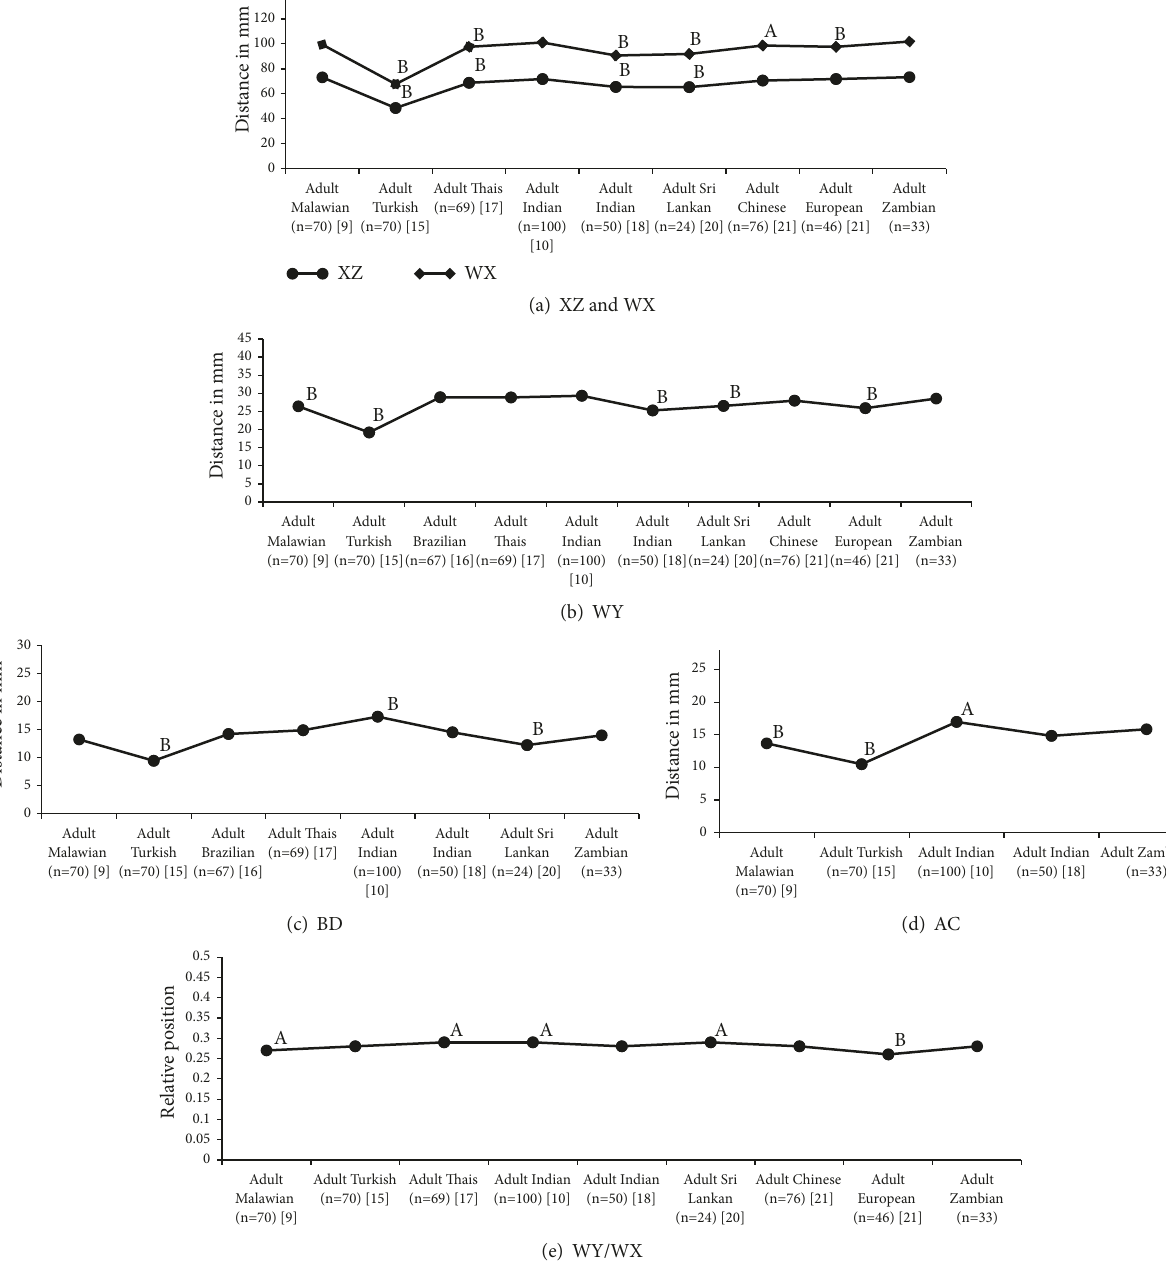
Figure 7: The mandibular anthropometrics of the right side of mandibles among different ethnic groups on different geographic locations: comparative analysis with other reported values. AC: distance (in mm) from alveolar crest to upper margin of mental foramen, BD: distance (in mm) from lower border of mandible to lower margin of mental foramen, WY: distance (in mm) from symphysis menti to medial margin of mental foramen, XZ: distance (in mm) from posterior border of ramus of mandible to lateral margin of mental foramen, WX: length of mandibles, and WY/WX: relative position. A Significant at p < 0.05; B significant at p <